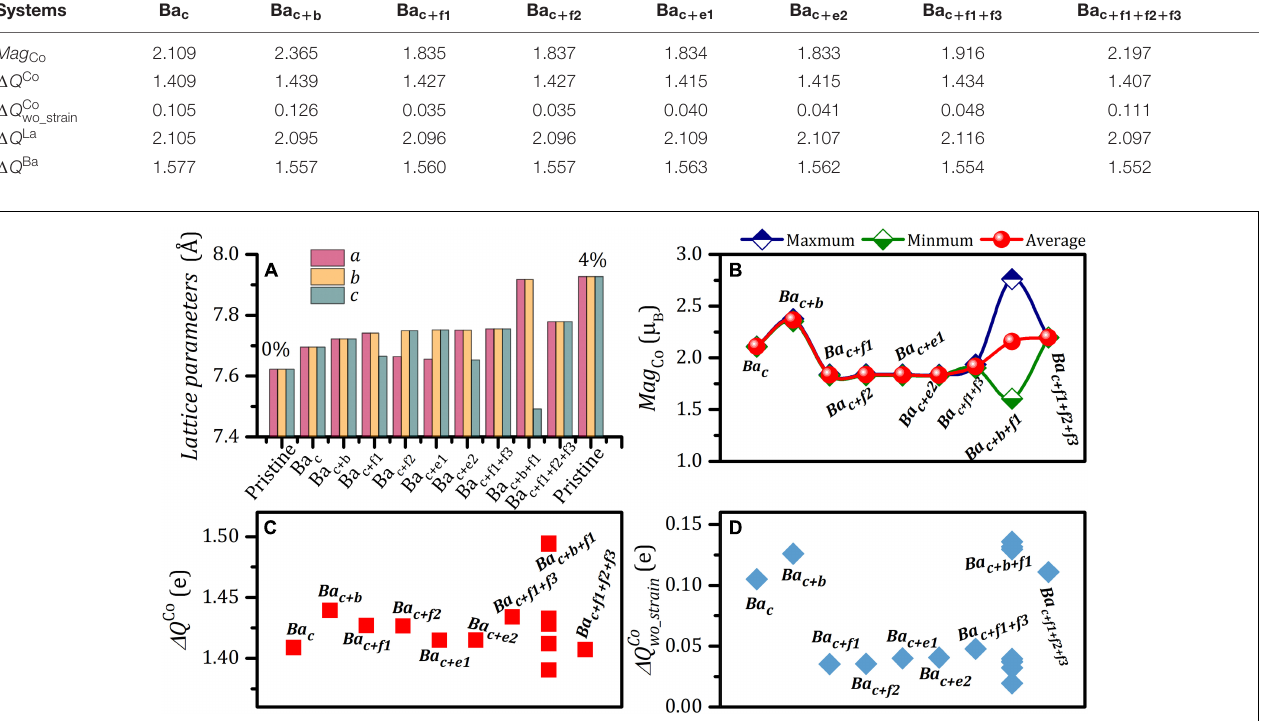
FIGURE 6 | (A) Lattice parameters along a, b, and c directions, (B) magnetic moment localized at Co atom (Mag Co ), (C) charge transfer of Co atom, and (D) charge transfer of Co atom excluding effect of variation in lattice in Ba-substituted LaCoO 3 .